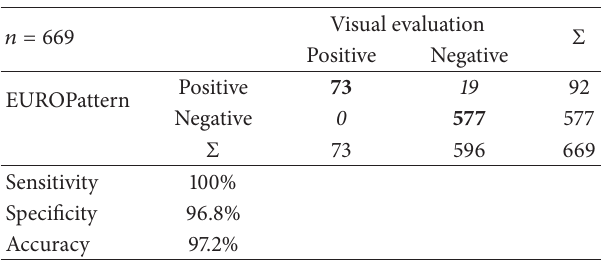
Table 1: Comparison of software-generated and visual posi- tive/negative classification including 669 analyzed